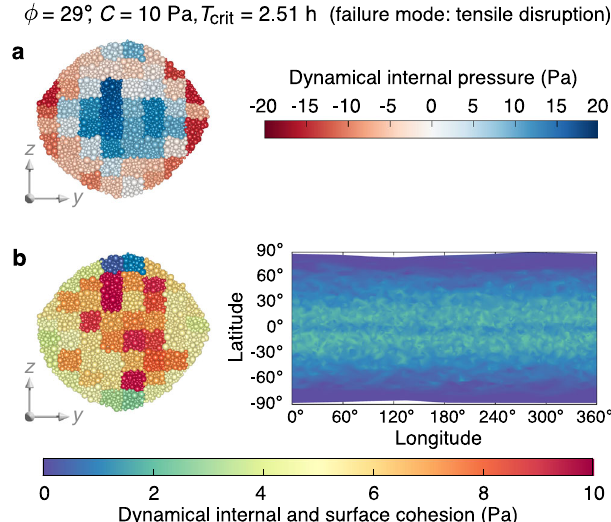
Fig. 3 | Pattern ofinternaland surface failure regions ofa cohesive rubblepile. Dynamical internal pressure ( a ; tensile stress is expressed as a negative value) and internal and surface cohesion map ( b ) at the critical spin limit T crit for a simulation with strong cohesion ( C =10 Pa). Regional failure is initiated when the local dyna- micalinternal/surfacecohesionexceedsthevalueofthecohesivestrength C ,which determines the failure behaviours as indicated on the top of this fi gure. The dynamical internal pressure and cohesion are calculated based on the averaged- stressanalysisusingrepresentativevolumeelements(thepatchesshownrepresent the elements in these cross-sections), and the dynamical surface cohesion is derived based on the rubble-pile alpha-shape model (Methods). Source data are provided as a Source Data fi